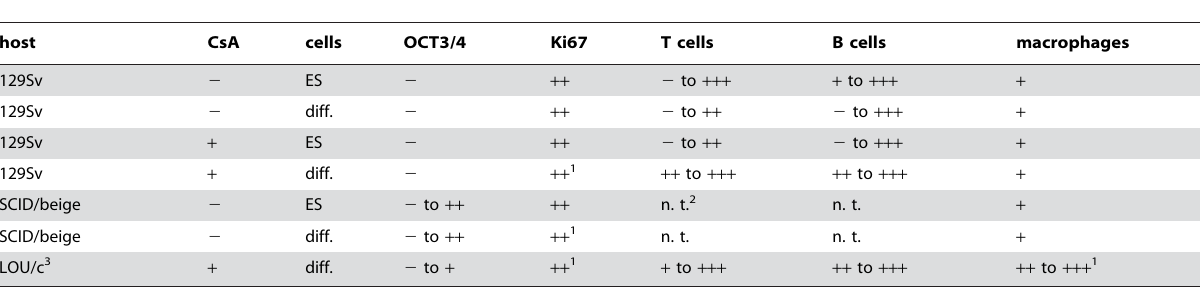
Table 3. Results of immunohistochemical stainings of teratomas grown in various hosts.